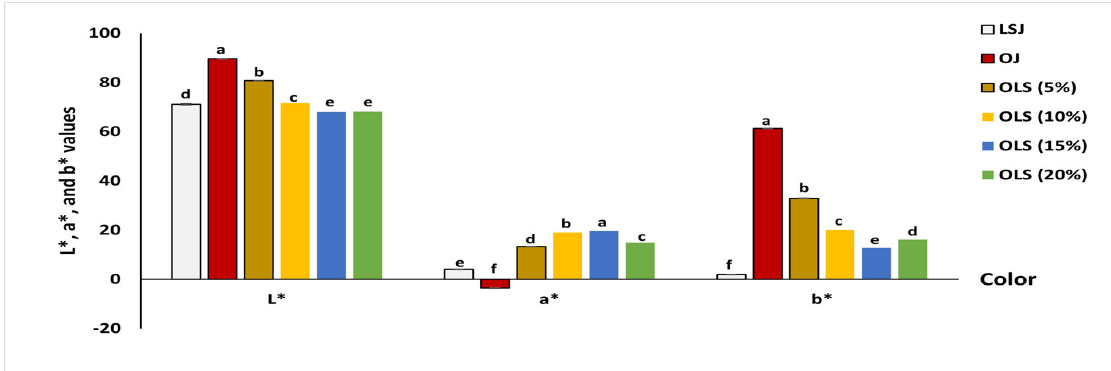
Figure 1. Color of orange juice mixed with beetroot leaf–stem juice in different proportions. Columns in each group labeled with different letters are significantly different at p < 0.05.